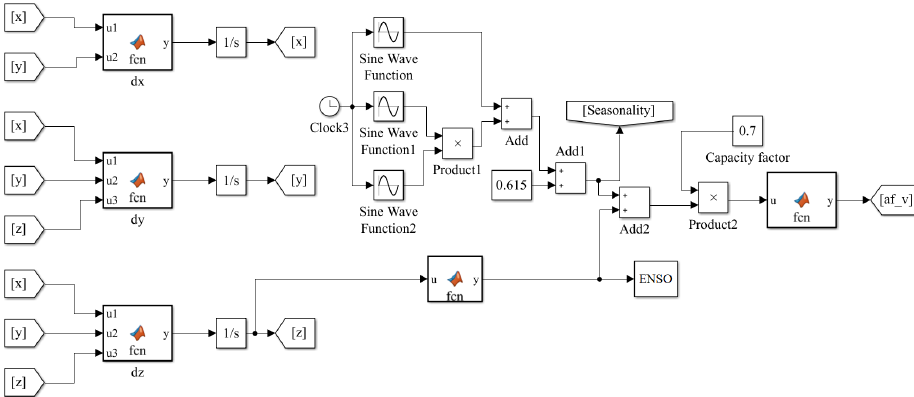
Figure A4. Availability factor of the variable generation af v